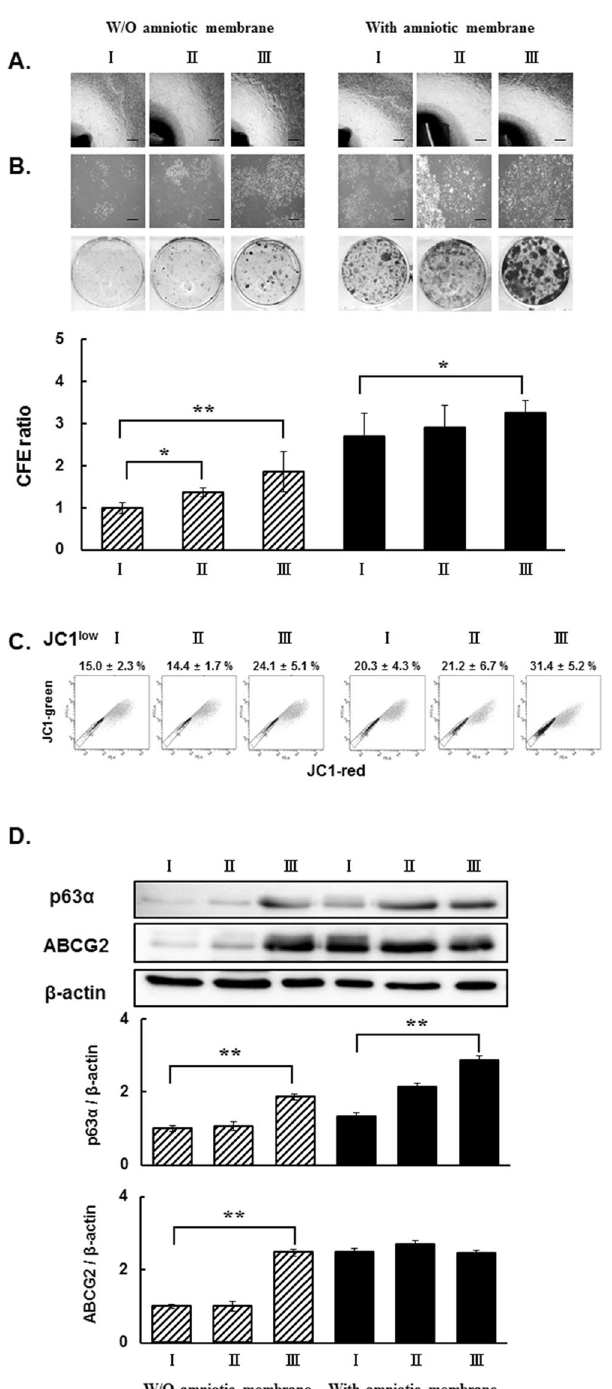
Figure 1. Effects of culture media on activation of limbal stem/progenitor cells in limbal explant outgrowth sheets. ( A ) Representative phase contrast micrographs of limbal explant and outgrowths in culture medium complemented with (I) 5% FBS with CT, (II) 5% FBS without CT, and (III) 5% human serum without CT using transwell (without; W/O amniotic membrane) and amniotic membrane. Bar = 50 µ m. ( B ) Representative phase contrast micrographs of holoclone colonies from outgrown cells from limbal explant (upper). Photographs of colonies stained with Coomassie blue R solution (lower) and CFE ratio. ( C ) Representative JC1 staining bivariate plots of limbal explant outgrowth cultures with JC1 exclusion cell cohort (JC1 low ) indicated. Mean ± SD for three independent experiments are shown within the plots. (D ) Representative western blot image on p63 α and ABCG2 protein expression. All signal intensities were normalized to the signal generated in the same sample by β -actin. * p < 0.05, ** p < 0.01 (n = 6 from 3